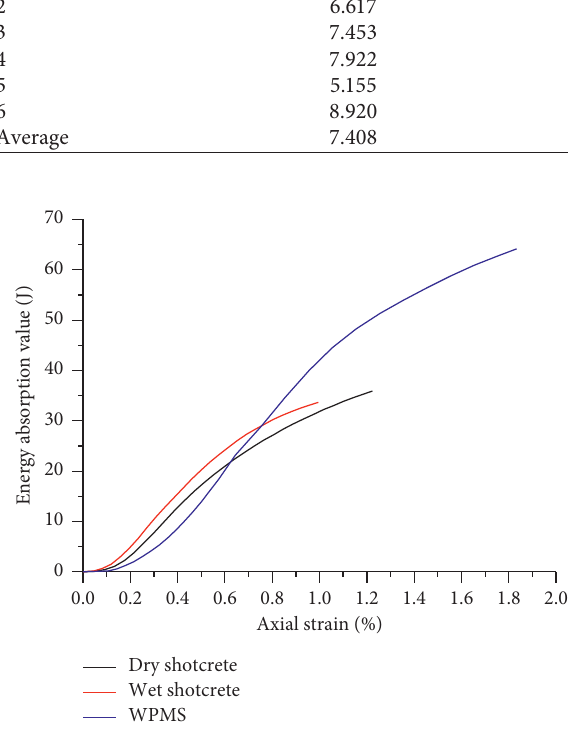
Figure 4: Energy absorption (v). Axial strain in three different shotcrete mixes.